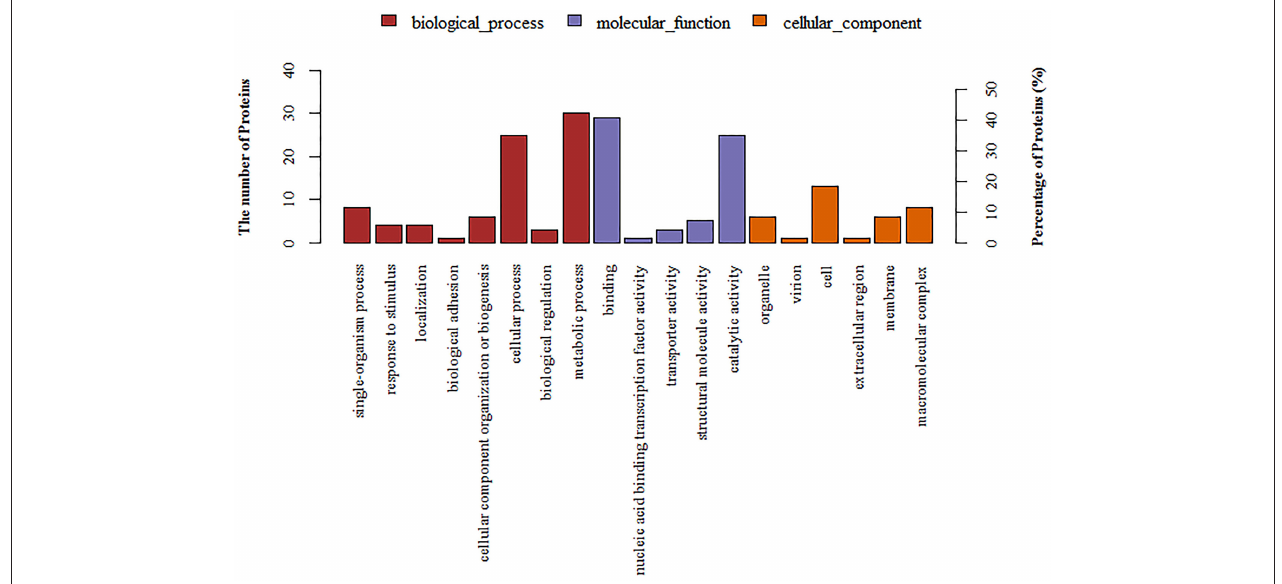
FIGURE 4 | Annotation of differentially regulated protein (ratio > 1.5 or < 0.67) functions by Gene Ontology